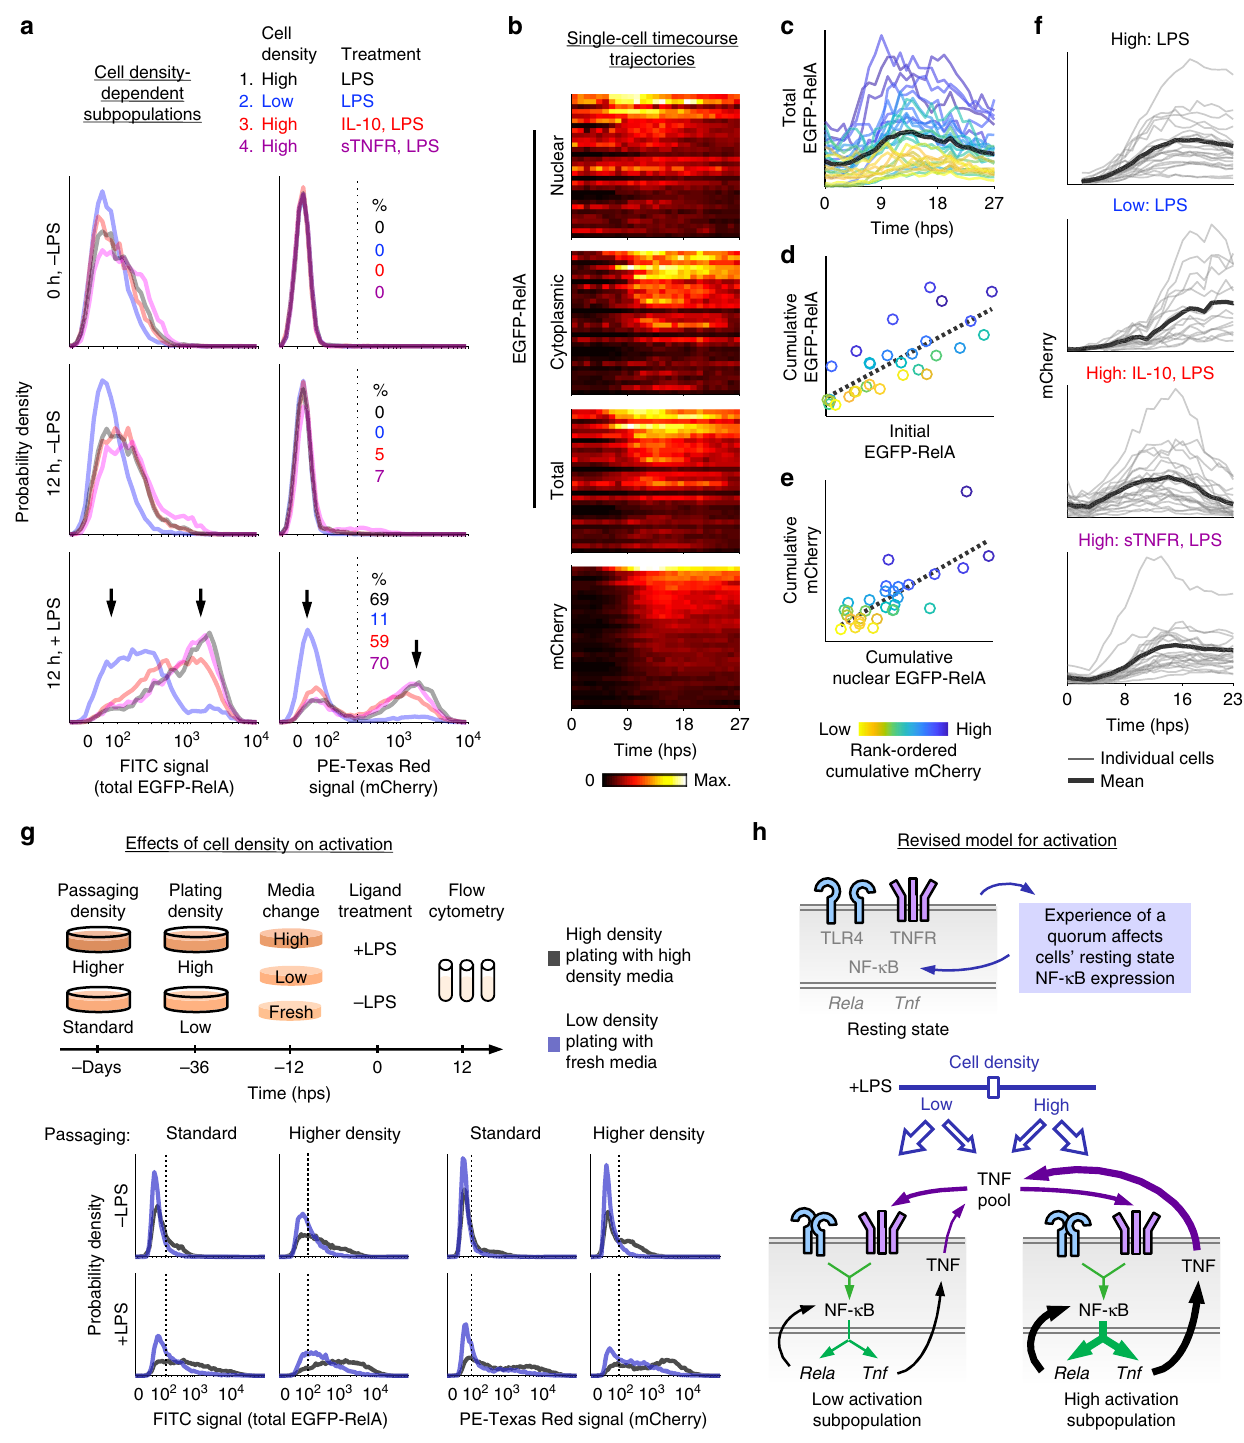
Fig. 2 Cell density modulates the heterogeneity of macrophage activation. a Reporter protein fl uorescence was measured by fl ow cytometry for the indicated cell densities, time points, and ligand treatments (IL-10 and sTNFR treatments as in Fig. 1). Percentages of highly activated cells were determined using a threshold (dotted vertical line) at the nadir between the two modes (arrows) of mCherry distributions. b Reporter trajectories for n = 30 cells at high density after treatment with sTNFR and LPS. Cells are ordered by cumulative mCherry expression and color-coded by fl uorescence magnitude within heat maps. c Single-cell trajectories for total EGFP-RelA expression. The mean is in bold. d – e Relationship between initial and cumulative total EGFP-RelA ( R 2 = 0.61, one-tailed permutation test p = 2 × 10 − 7 ) and between cumulative nuclear EGFP-RelA and cumulative mCherry ( R 2 = 0.59, one-tailed permutation test p = 3 × 10 − 7 ). Dotted lines are linear fi ts, and axes are linearly scaled. In c – e , color-coding denotes rank-ordered cumulative mCherry expression. f Single-cell mCherry trajectories, with the mean in bold. Values are in a.u. speci fi c to each panel. g Effect of culture density-associated conditions on macrophage activation heterogeneity. Fluorescence units are comparable within each reporter protein and passaging density. Dotted vertical lines distinguish low and high activation. h Revised conceptual model for macrophage activation with differently activated cell density-dependent subpopulations. Source data are provided as a Source Data fi